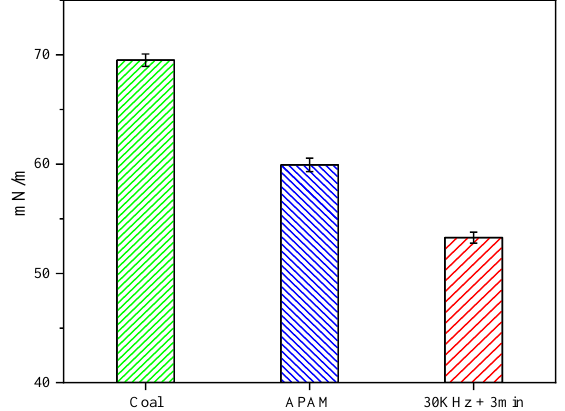
Figure 12. Surface tension of the filtrate under different conditions.